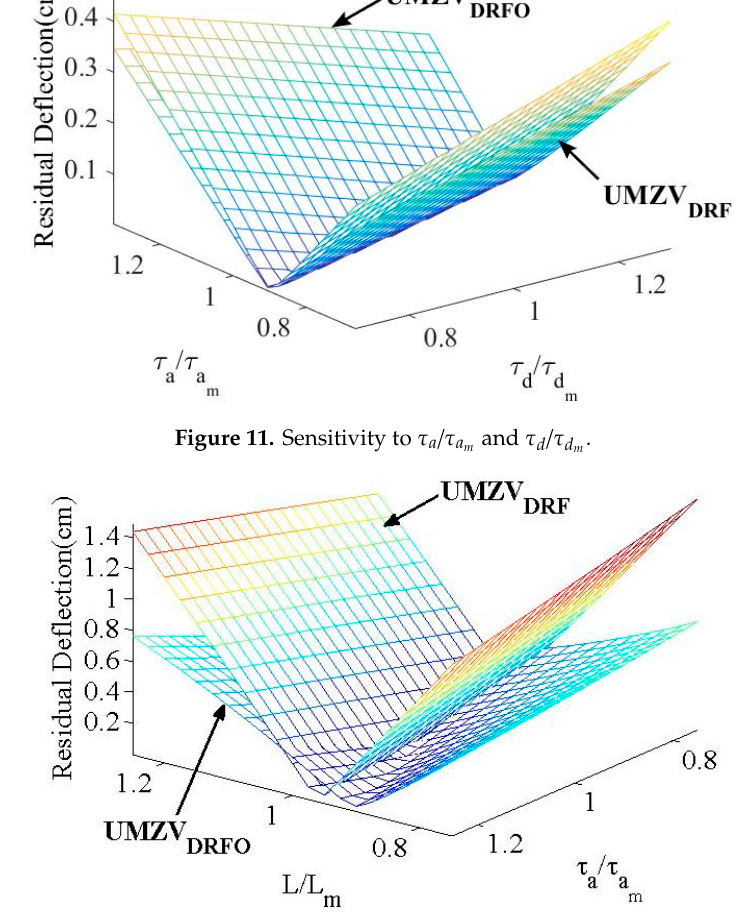
Figure 12. Sensitivity to τ / τ / L a a m and L m (cid:3288) and (cid:1838) / (cid:1838) (cid:3040) .